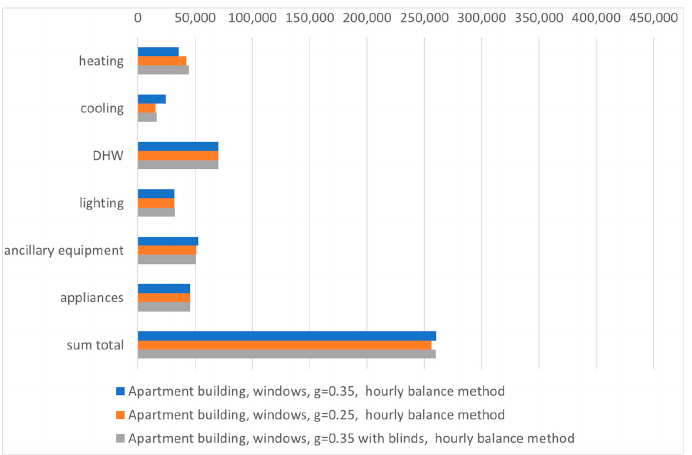
Figure 15. The primary energy demand of glazings and windows with and without solar blinds for the residential building.